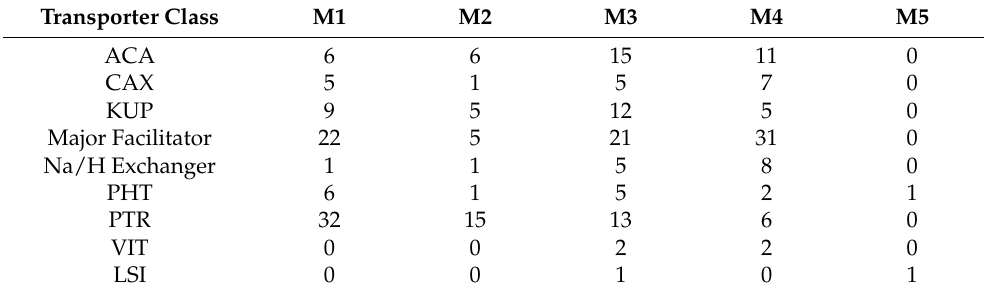
Table 1. Numbers of select genes encoding different classes of transporters found in Modules